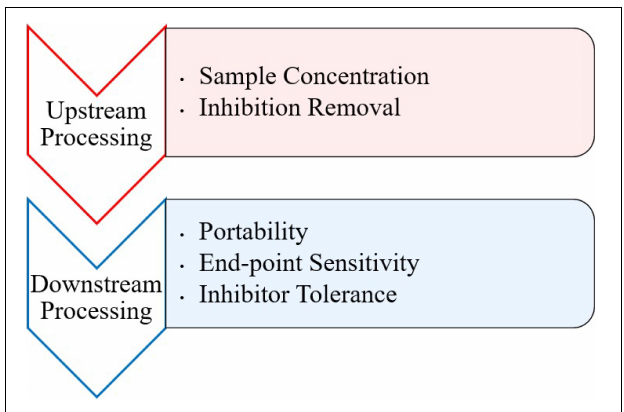
FIGURE 1 | Future perspectives for foodborne viral isothermal amplification